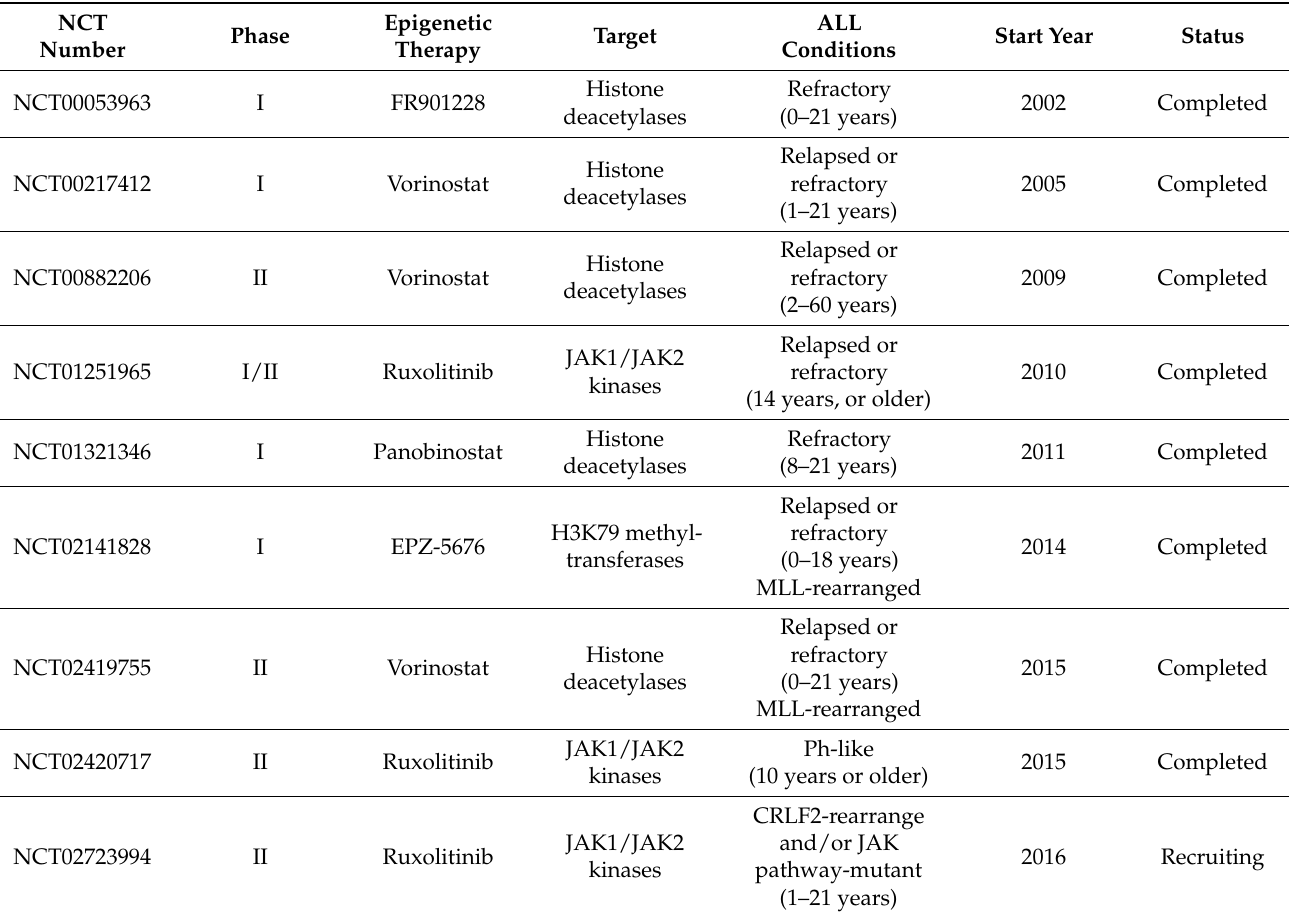
Table 2. Clinical trials targeting or potentially targeting histone modifications in